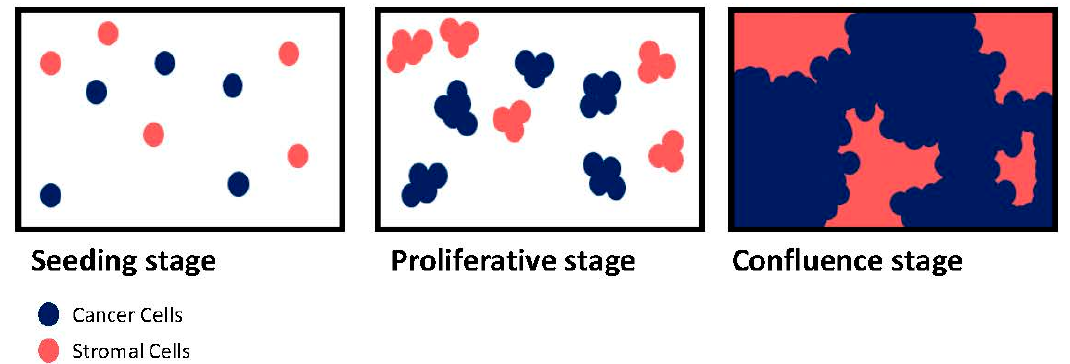
Figure 3. Cancer and stromal cells co-culture in 2D. Schematic illustrates cell behavior at different stages (seeding, proliferative phase, and confluence) of a 2D culture model. Stromal cells (in red) and cancer cells (in blue) have the same access to the media growth factors. Cells with contact inhibition (stromal cells) slow down their division while the space availability decreases until complete stop. Cells with no contact inhibition (cancer cells) keep proliferating and start to grow on the top of other cells.